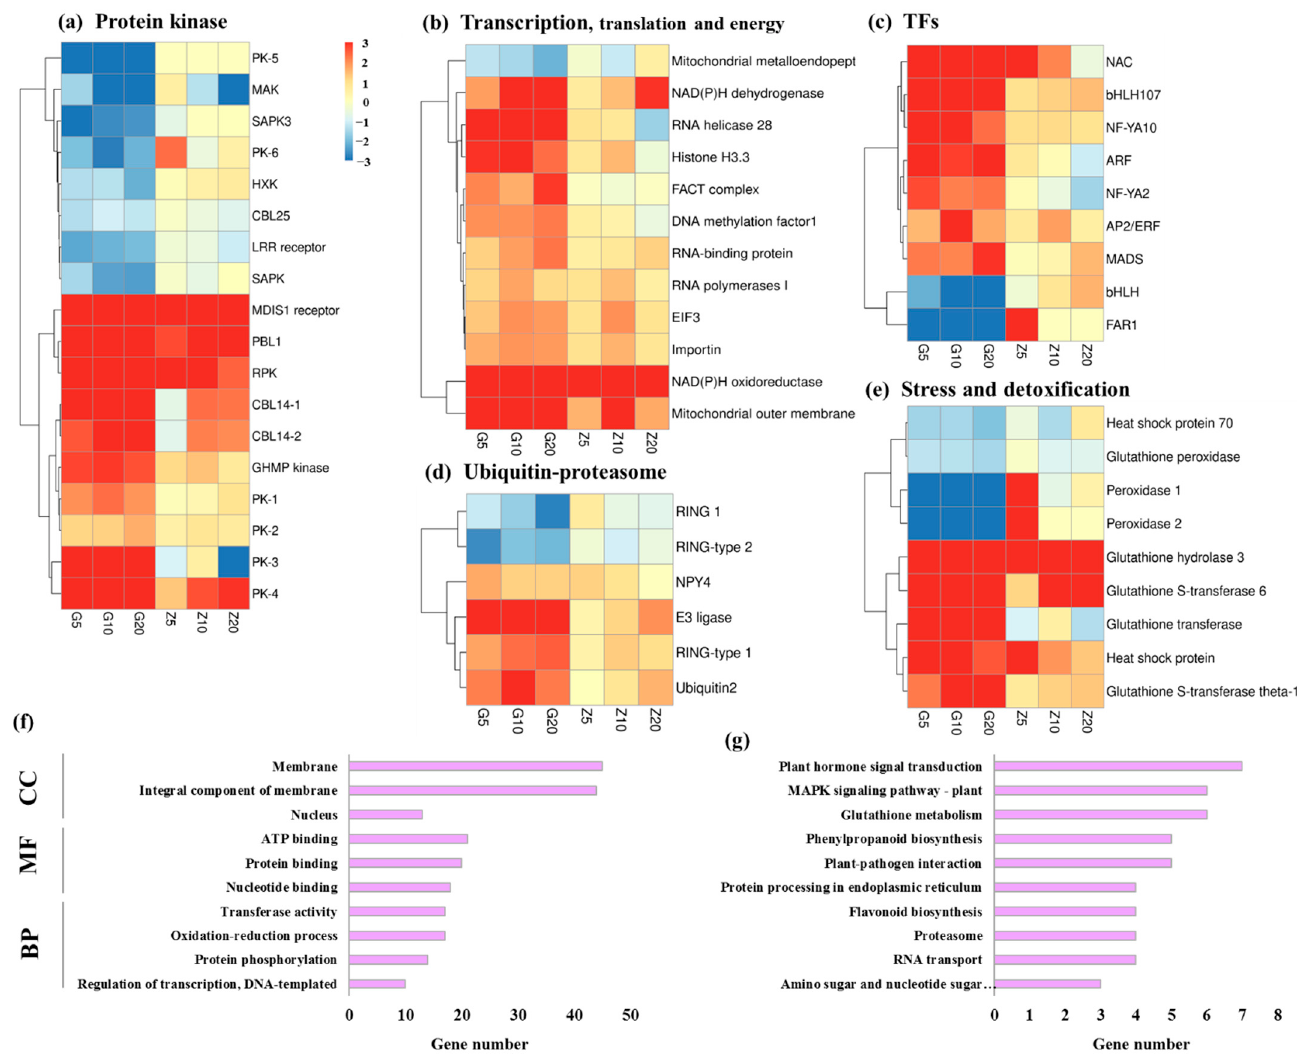
Figure 3. Heatmaps showing expression changes of some potential genes in GP-specific DEGs. ( a ) Protein kinases. ( b ) Transcription, translation and energy metabolism. ( c ) Transcription factors. ( d ) Ubiquitin–proteasome. ( e ) Stress and detoxification. ( f ) Top 10 categories of GO enrichment of these genes. ‘BP’, ‘MF’ and ‘CC’ represent ‘biological process’, ‘molecular function’ and ‘cell component’, respectively. ( g ) Top 10 categories of KEGG pathway of these genes.